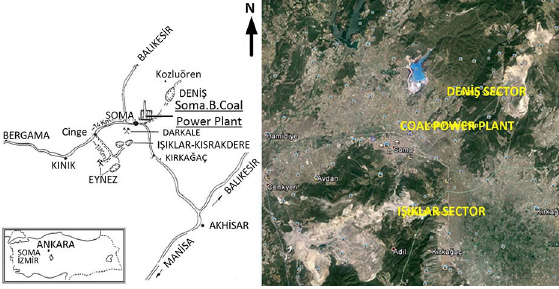
Fig. 4. Location of reserve areas and thermic power plant